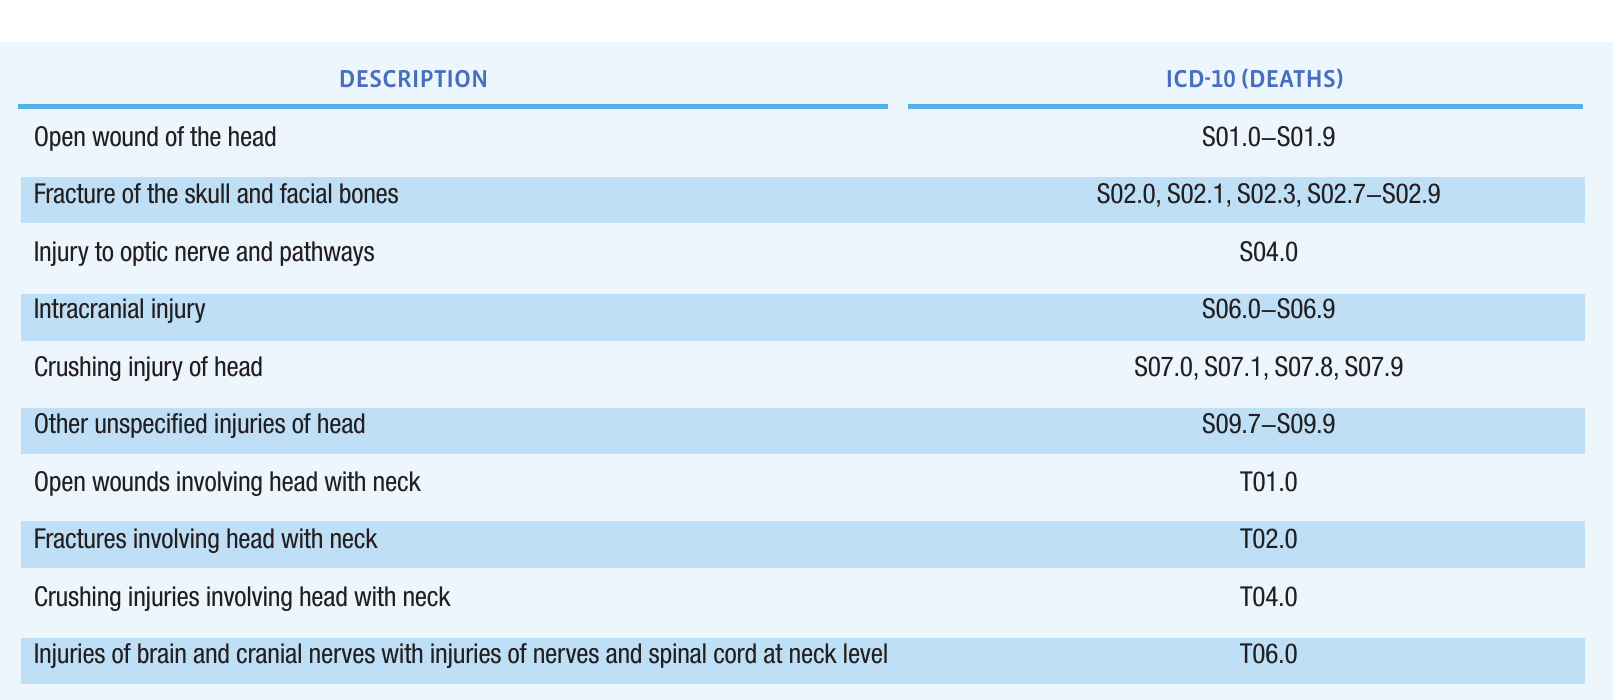
TABLE 19: ICD-10 Codes for Traumatic Brain Injury-Related Deaths (2002–2006)